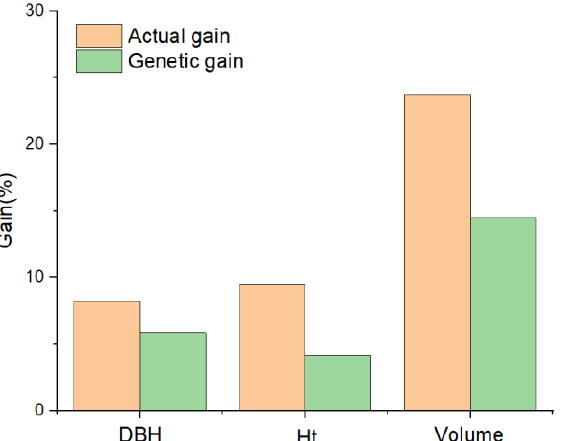
Figure 5. Actual and genetic gains of growth traits under a selection intensity of 1.4.